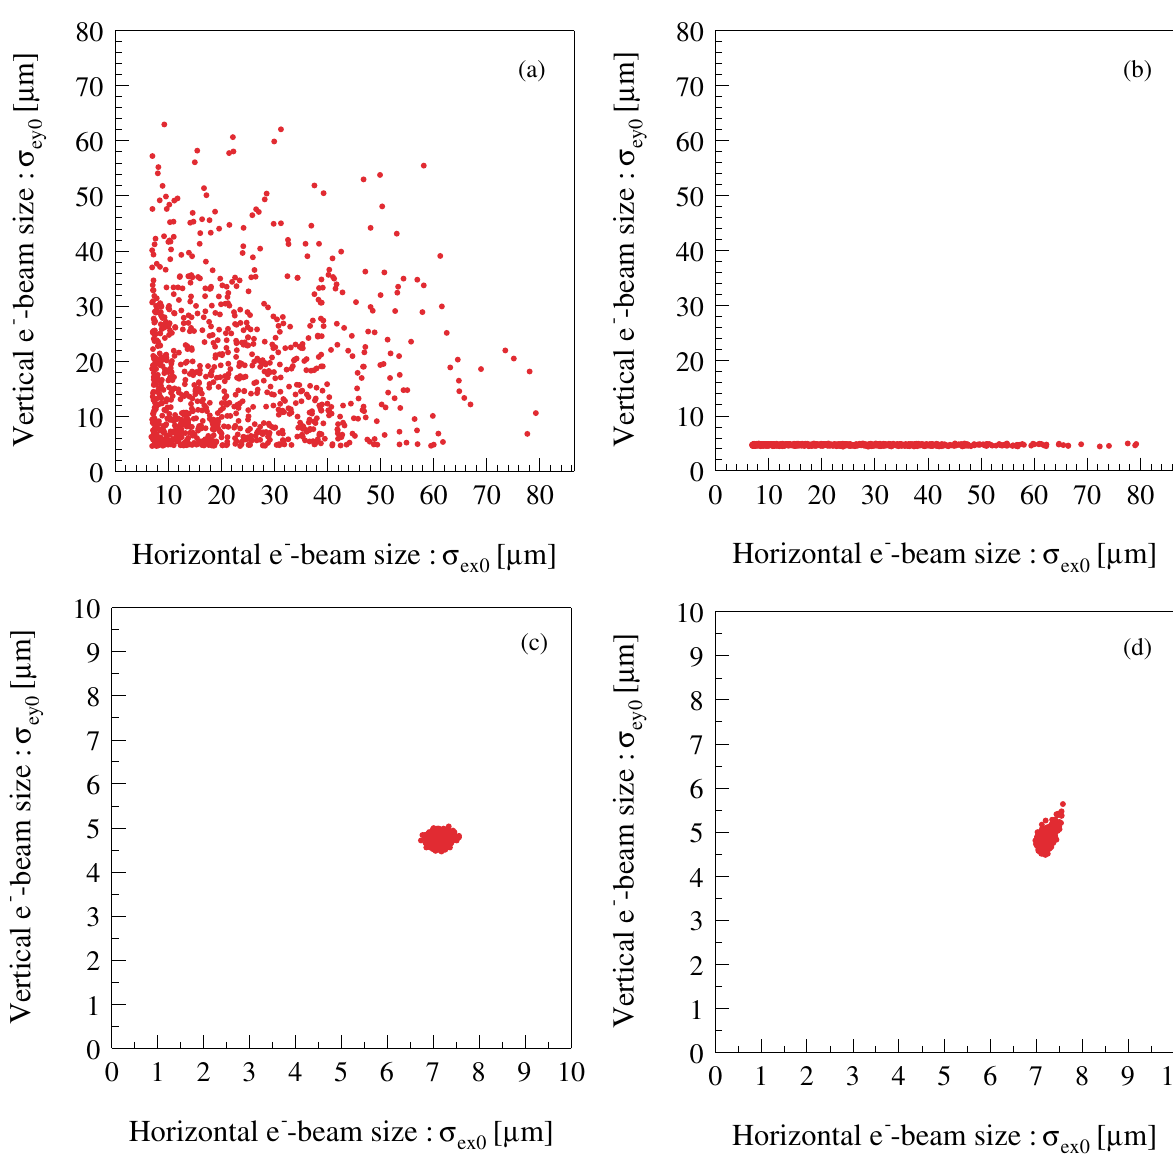
FIG. 8. (Color) Two dimensional plot of vertical and horizontal beam sizes simulated by SAD : (a) without the error correction for the Q magnets; (b) after the error correction for QY ; (c) after the error correction for QY and QX ; (d) after the error and dispersion corrections for QY , QX , and QD